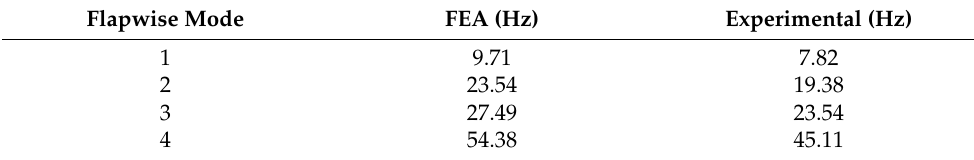
Table 8. Comparison between the FEA and experimental flapwise natural frequencies.